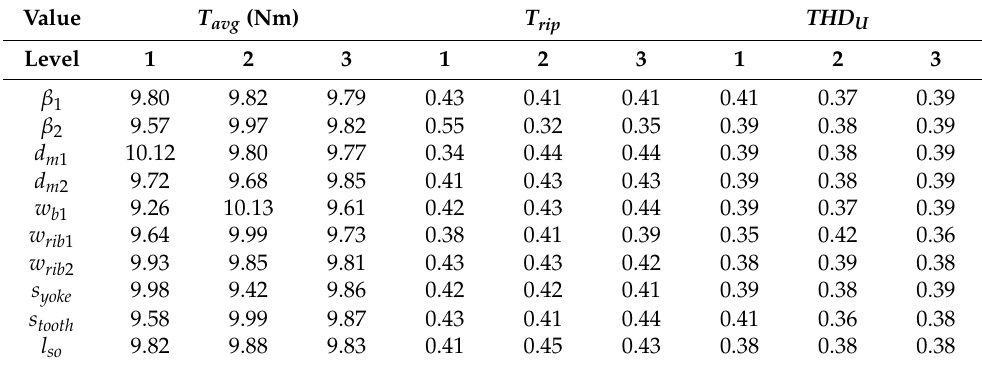
Table 4. The Average Value of